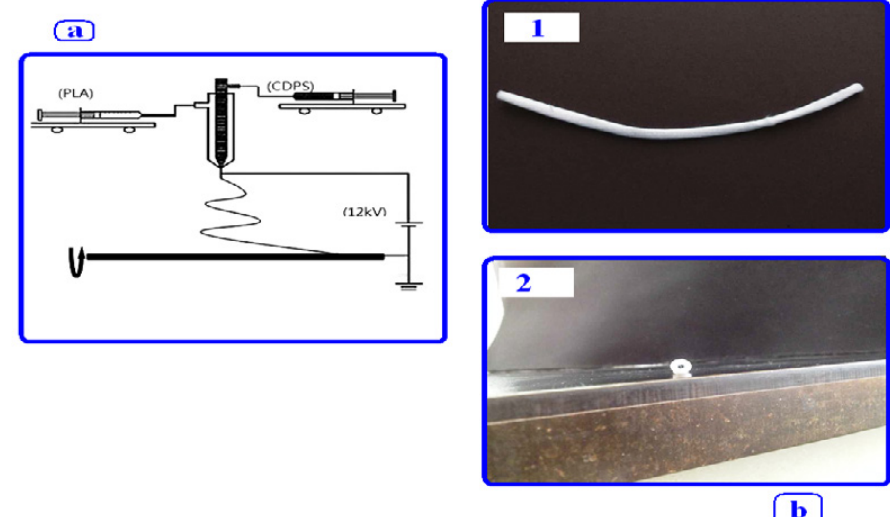
Fig. 7. (a) Co - axial electro - spinning apparatus. The voltage was regulated to constant 12 kV and the distance of coaxial facility to round bar was 10 cm. The flow rate of PLA organic solution and CDPS aqueous solution was 4, 1 (mL/h). A whole scaffold was fabricated with 2 h; (b) 1 - Platform of scaffold. The scaffold was 8.7 cm in length and presented white; 2 - The cross section of scaffold. The scaffold was hollow and the diameter of cross section was 0.42 cm; (c) 1 - Cross - section of the microfiber. The microfiber was produced to form core - sheath structure by means of co - axial electro - spinning technology (500×); 2 - SEM graph of transplanted scaffold (15 days) [98].